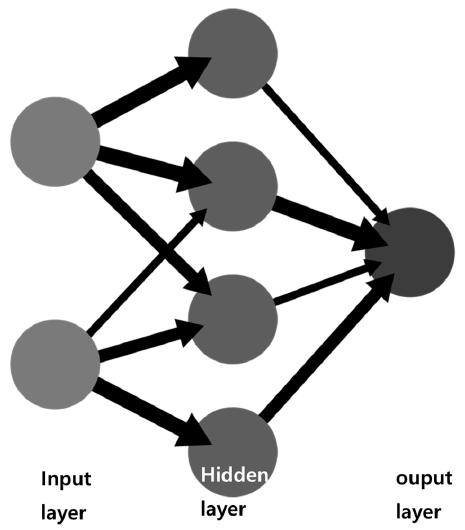
Figure 3. A simple and generic neural network model.